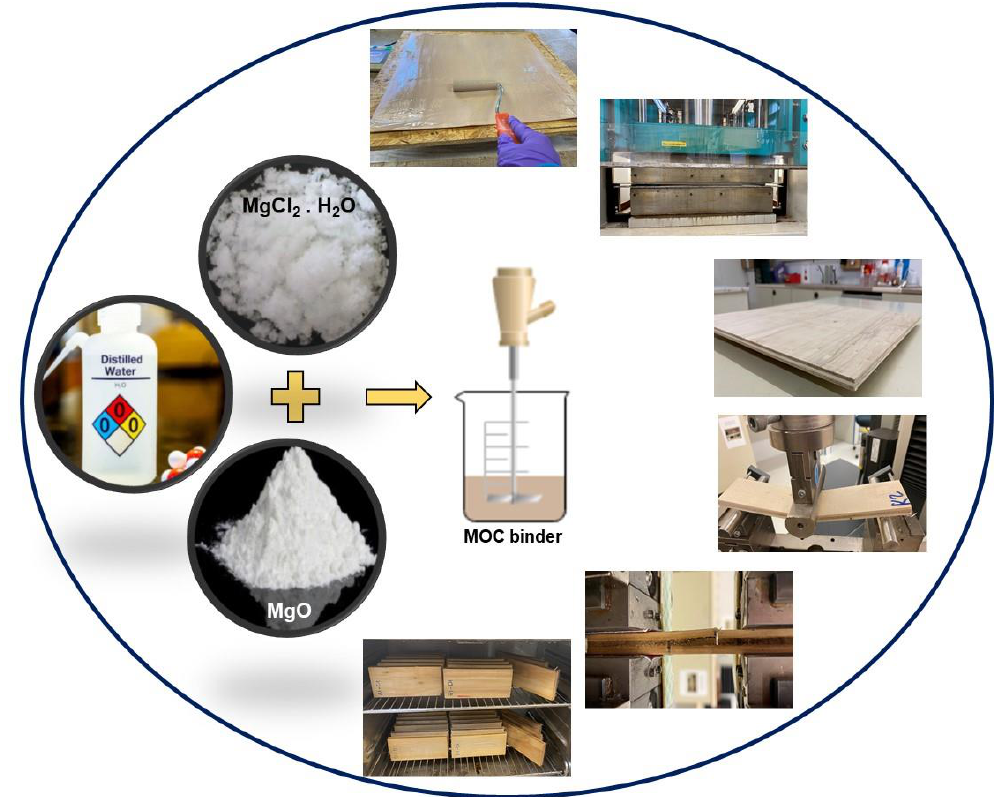
Figure 1. Manufacturing process for MOC binder and the plywood panels made from MOC binder.